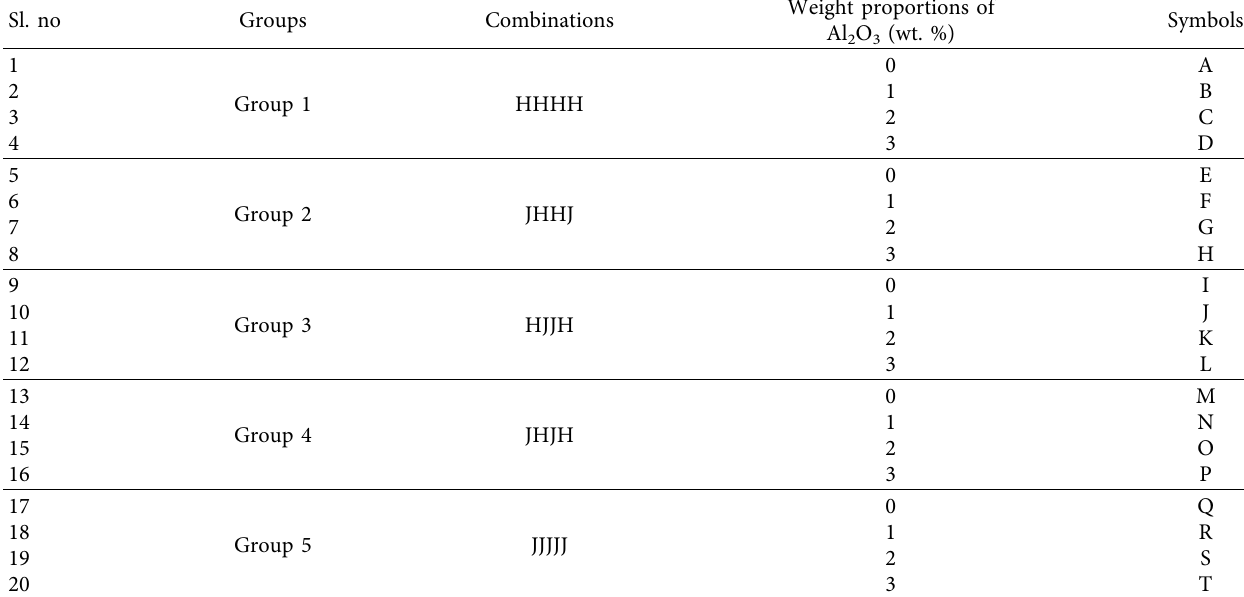
Weight proportions of Al 2 O 3 (wt. %)